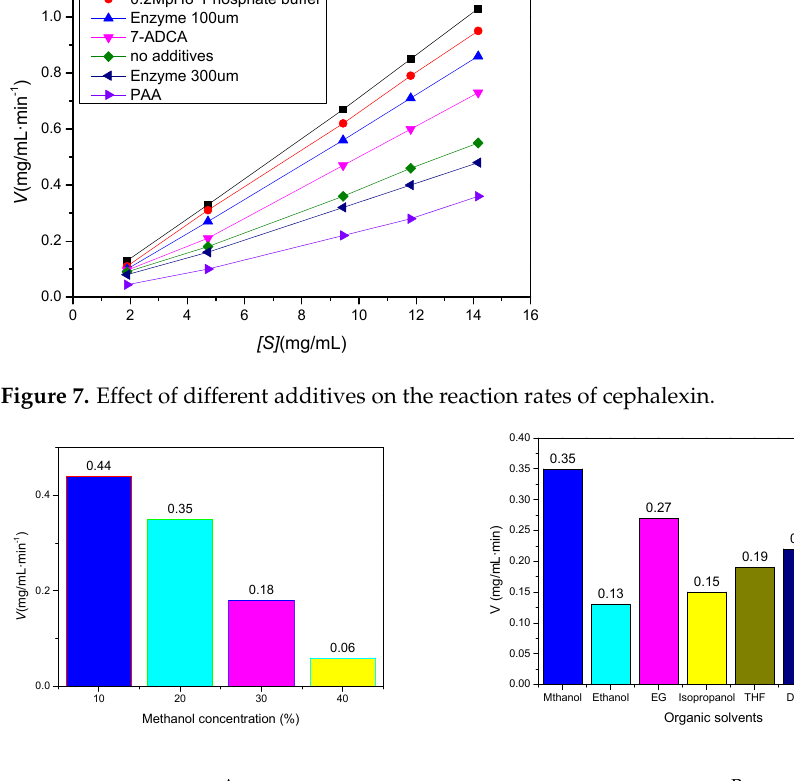
Figure 8. Effect of different concentrations of methanol ( A ) and organic solvents ( B ) on the reaction rate of cephalexin.